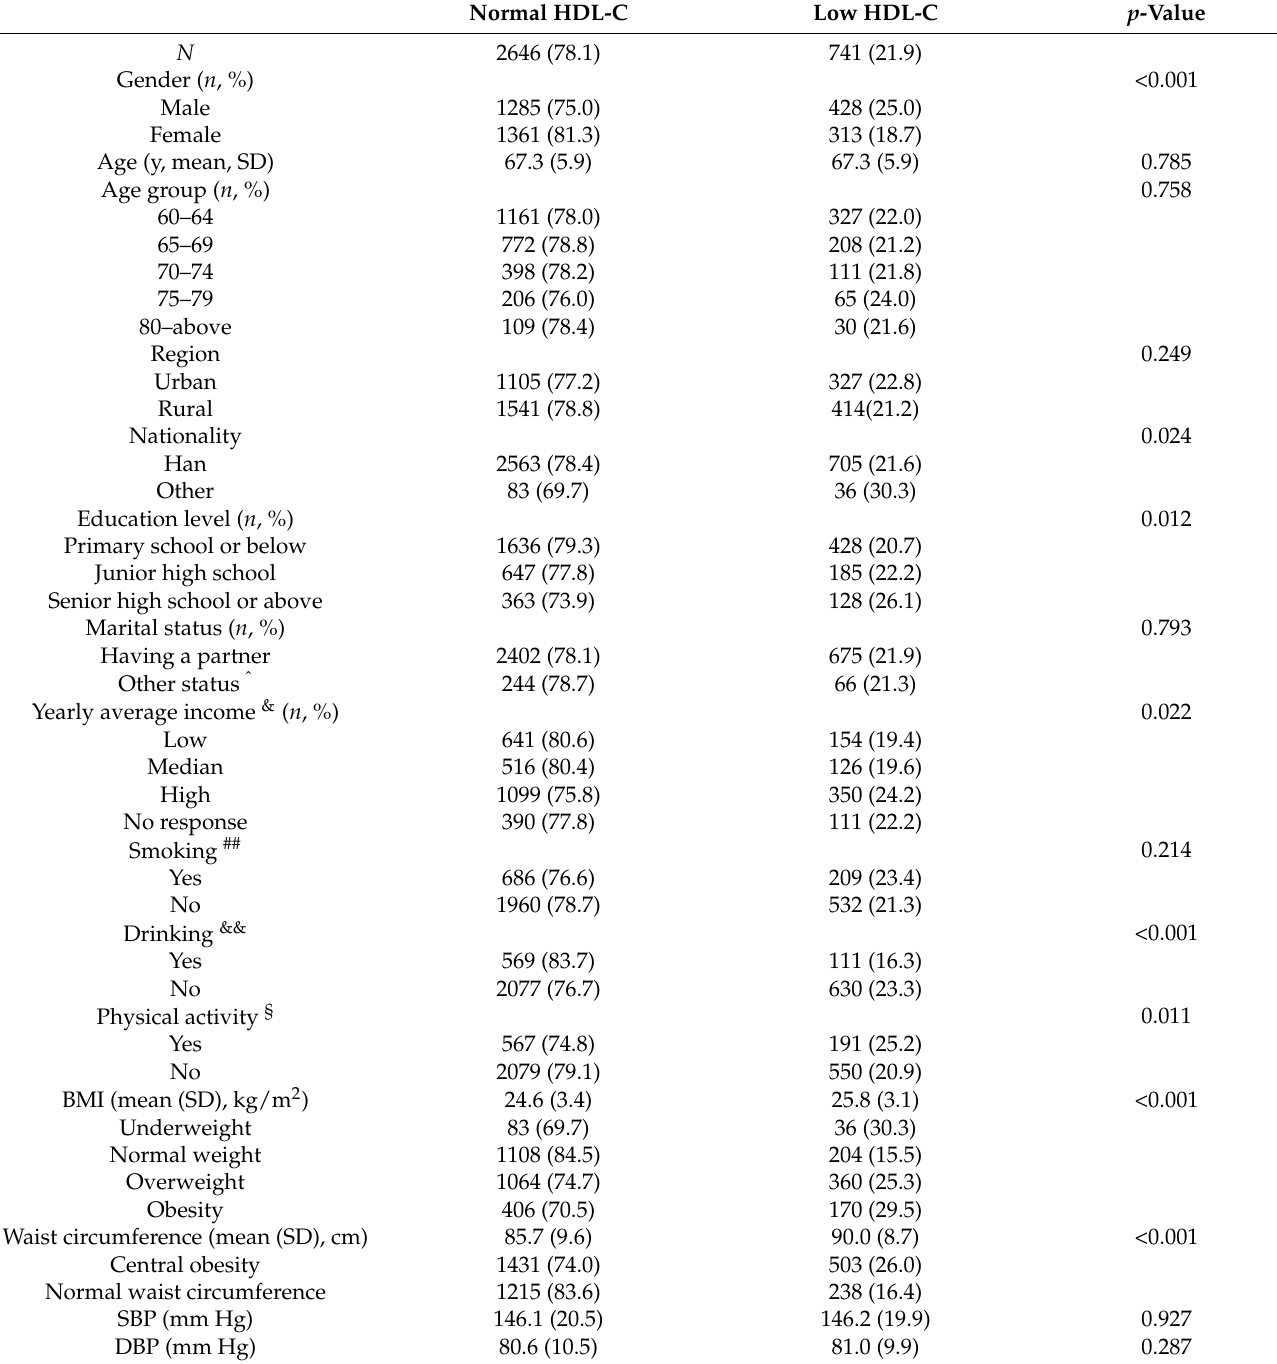
Table 1. Basic characteristics of older participants in the study living in North China. Normal